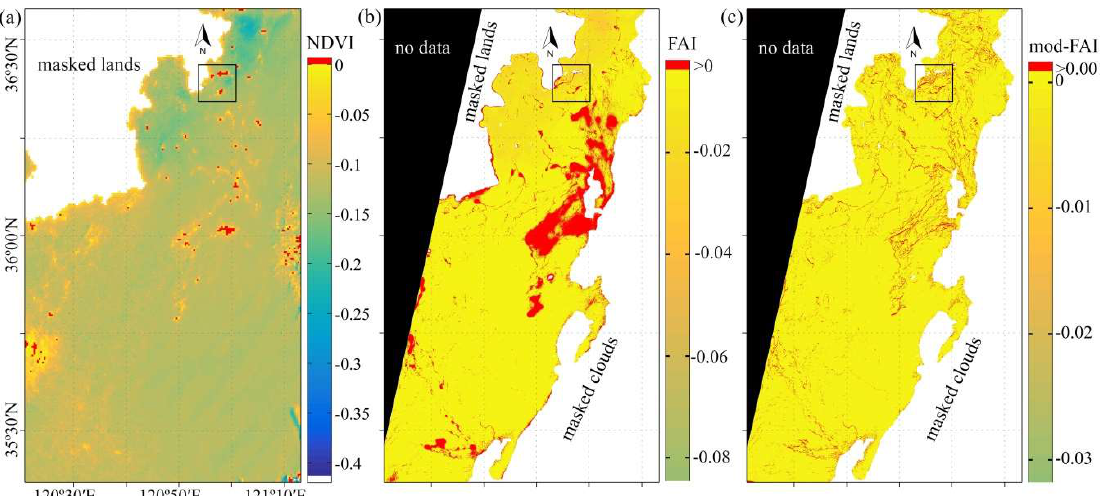
Figure 3. Comparison of macroalgal bloom detection results (dark red) between ( a ) Geostationary Ocean Color Imager (GOCI) normalized difference vegetation index (NDVI), ( b ) Landsat-8 FAI, and ( c ) Landsat-8 modified FAI. The GOCI image was acquired on 25 July 2015 03:31 UTC, and the Landsat-8 based images represent for ROI area inside path/row 119/35 image (large black rectangle in Figure 1) at 02:30 UTC on the same date. The small ROI area inside each image is marked by a black rectangle.